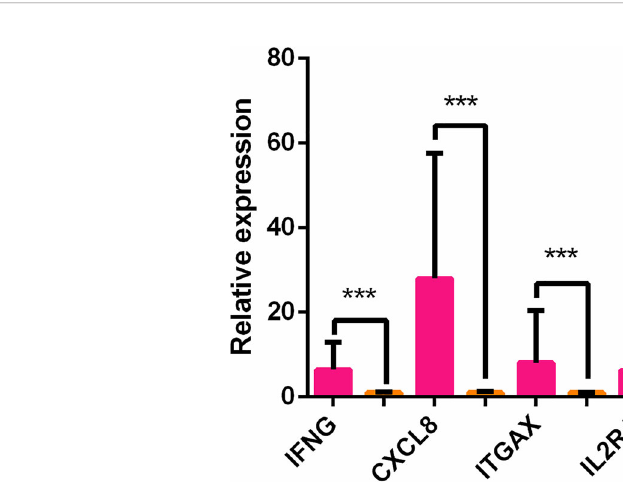
FIGURE 4 | Different expression of the top 5 hub genes in cases and controls veri fi ed using qRT-PCR. *** p <